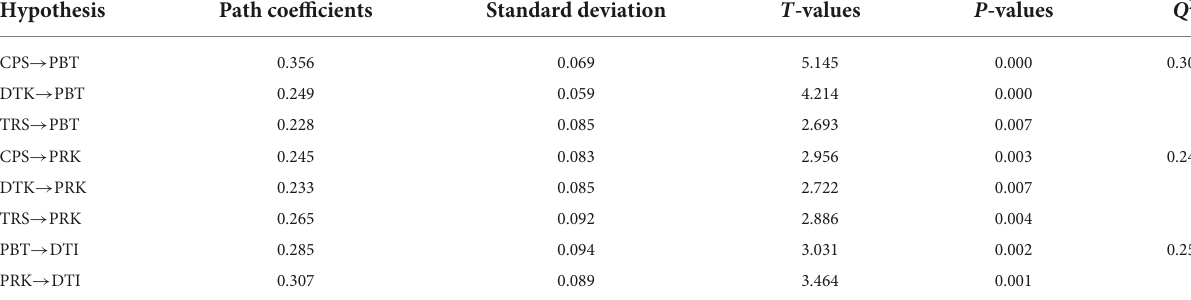
TABLE 4 Outer model results.